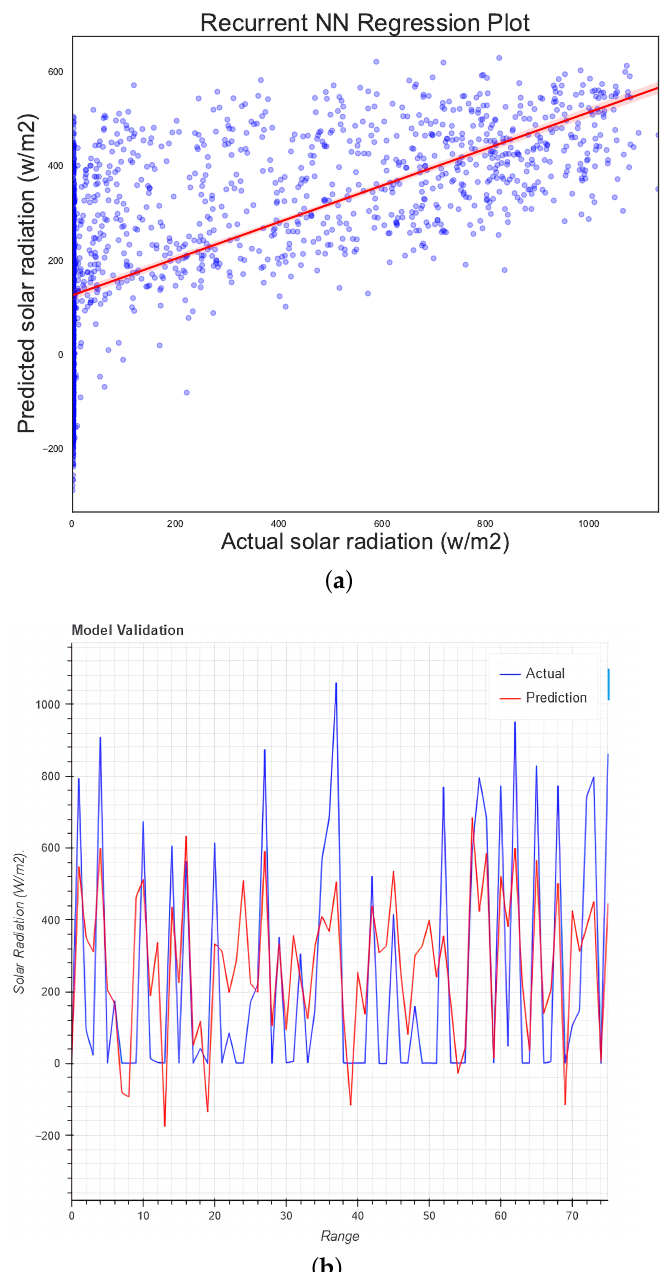
Figure 9. Regression plots for ( a ) the RNN model and ( b ) the test data using RNN